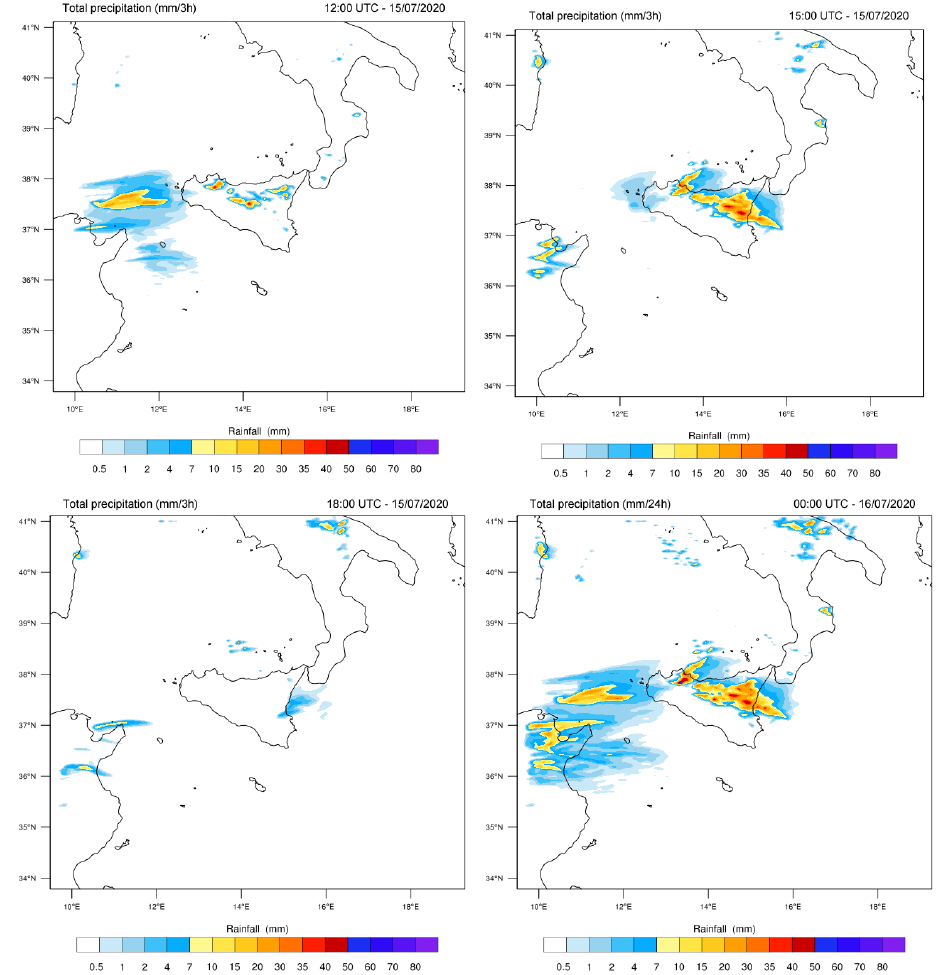
Figure 20. Cumulative rainfall every three hours predicted by the WRF model with a domain of 3 km and calculated at 12:00 UTC ( top left ), 15:00 UTC ( top right ) and 18:00 UTC ( bottom left ) of 15 July 2020. The cumulative rainfall calculated along the whole day are reported in the bottom right panel.